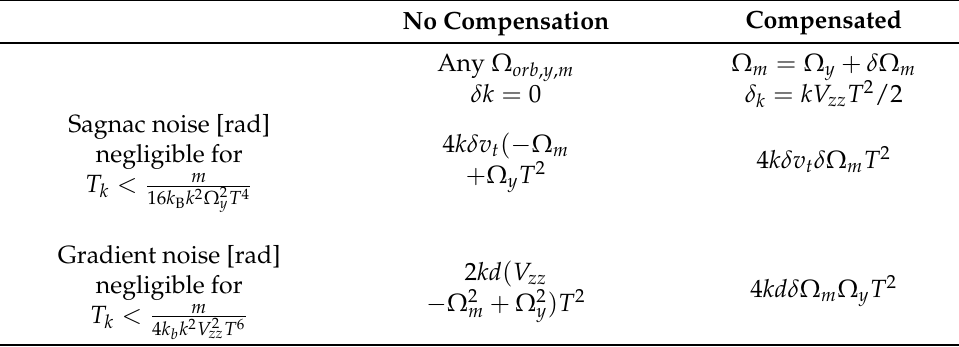
Table A1. Leading phase errors for differential CAI